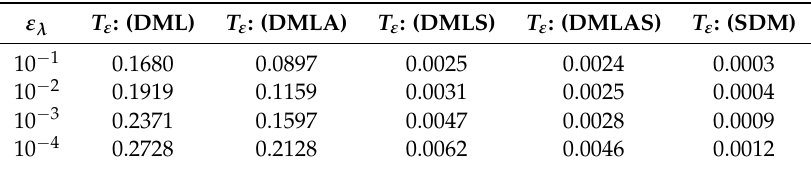
Table 1. Results for Case L with J = 510, m = 25.